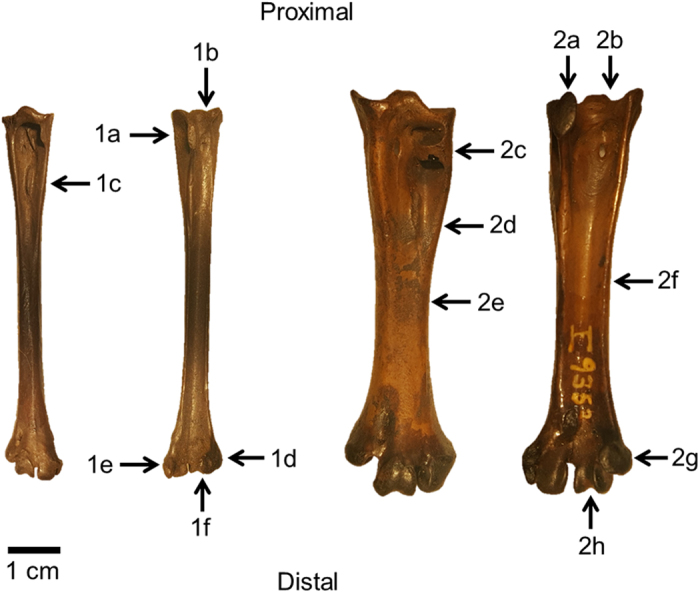
Tyto alba (1a–f) and Bubo virginianus (2a–h) tarsometatarsus morphology. Anterior view on left and posterior view on right for each specimen. (1a) Pronounced calcaneal ridge; (1b). Hypotarsus with wide, open tendinal canal; (1c). Deep anterior groove at proximal end of shaft; (1d). Fourth trochlea short and deflected backward; (1e). Second trochlea deflected backward; (1f). All trochlea closely crowded, little extended. (2a) Pronounced calcaneal ridge; (2b). Wide, deep tendinal groove; (2c). Arched, ring-like canal on anterior face of shaft at proximal end; (2d). Deep anterior groove; (2e). Shaft wide and flat; (2f). Deep posterior groove; (2g). Fourth trochlea elevated; (2h). Second and third trochlea on same level.